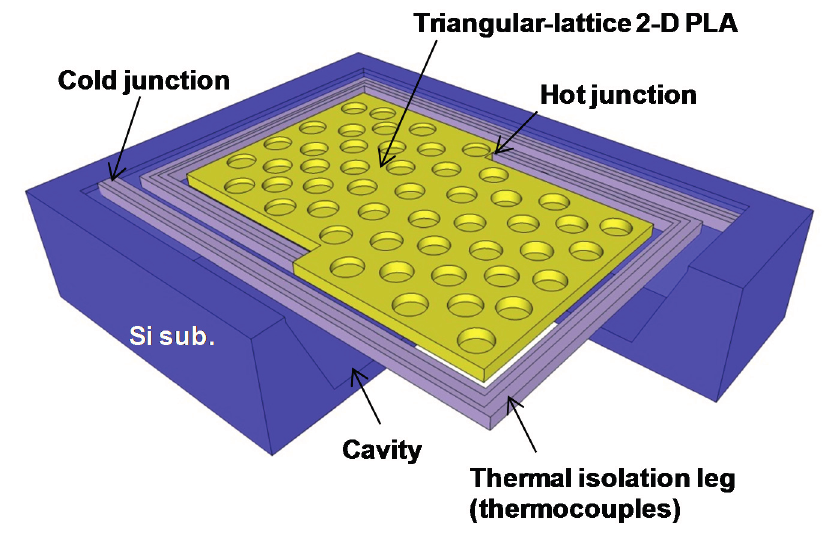
Figure 2. Schematic of the MEMS-based thermopile with a triangular lattice 2-D